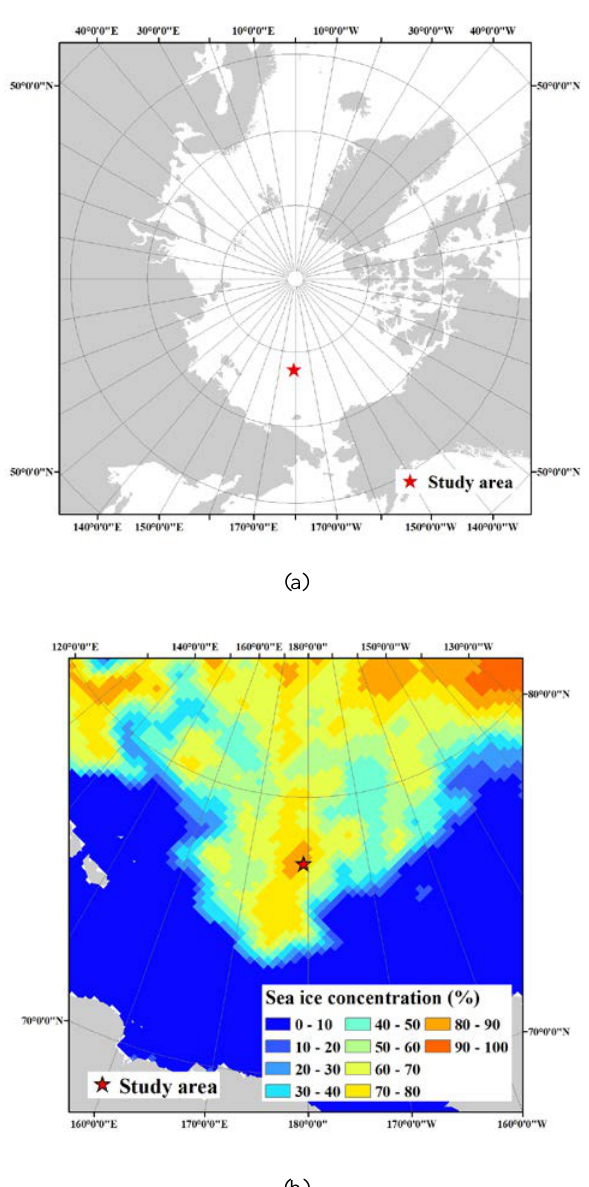
Figure 1. Overview of study area: (a) location of the study area and (b) sea ice condition data from NSIDC around the study area on August 14, 2017.